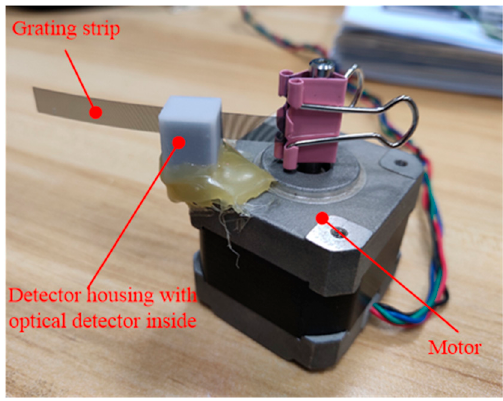
Figure 9. Durability test of grating strip.